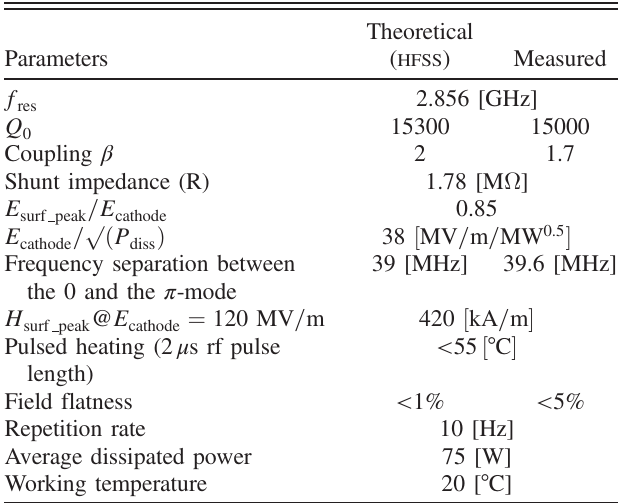
TABLE I. Radio frequency gun parameters theoretical ( HFSS ) and